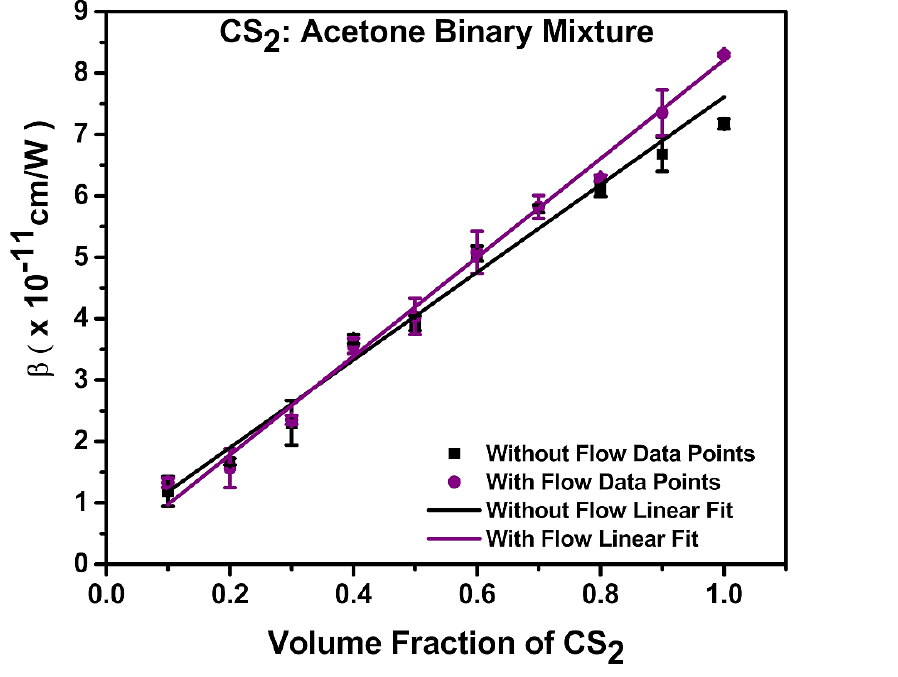
Figure 4 Variations of β with the volume fraction of carbon disulfide in the binary liquid mixture un- der both without-flow and with-flow experimental conditions. Full-size DOI: